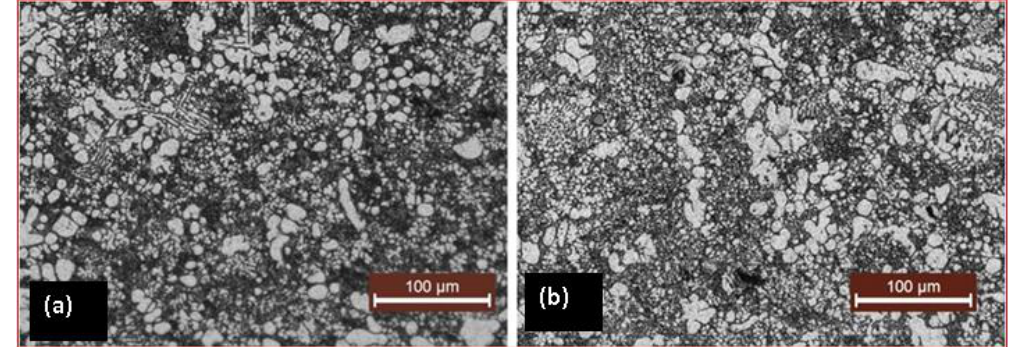
Figure 13: Representative optical microstructure of connectors (connector 1 here) for longitudinal (a) and transverse sections (b). Etchant: Keller’s